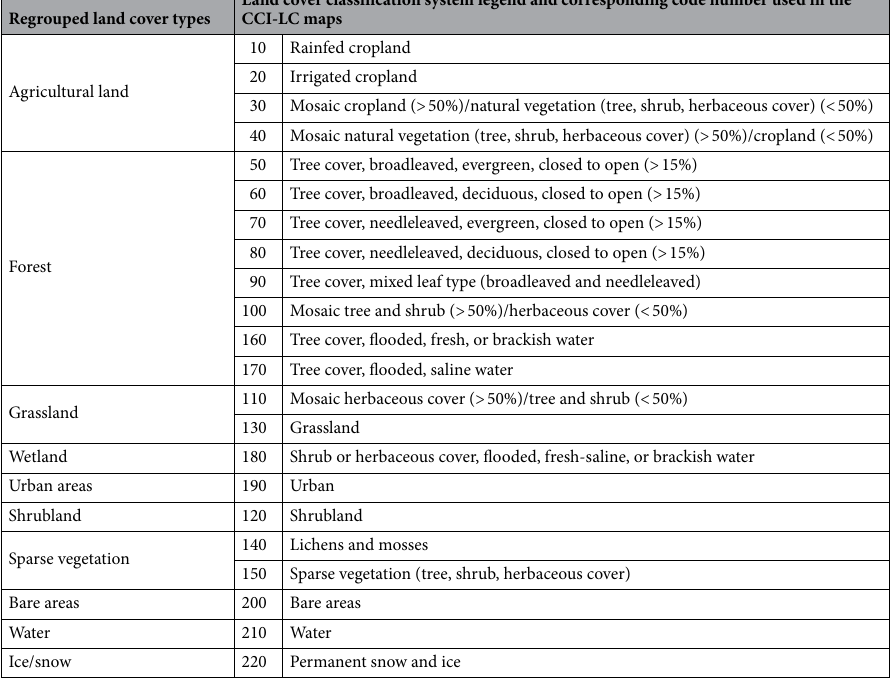
Table 1. Correspondence between our regrouped land cover types and the CCI-LC